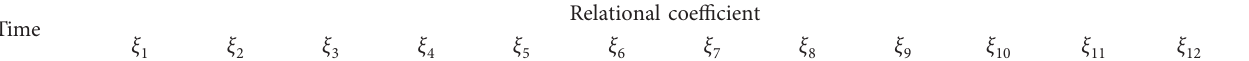
Table 5: Miners’ unsafe behavior for each sequence relational coefficient.